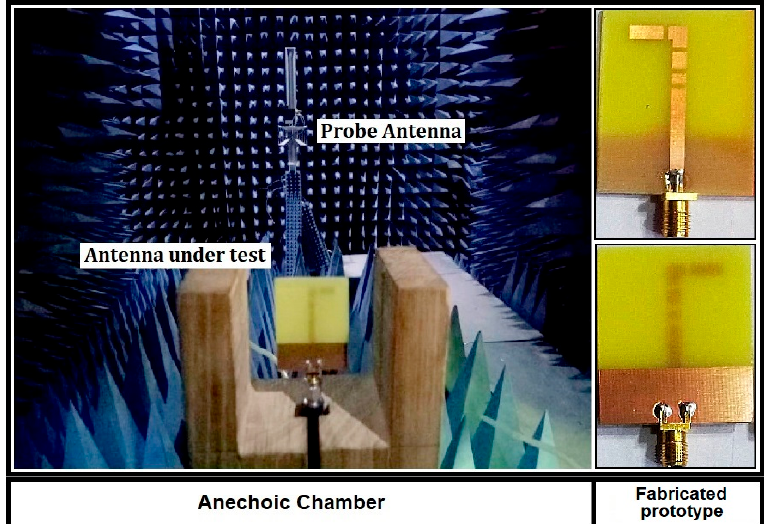
Figure 4. Setup for measuring radiation pattern of the proposed antenna in Mode 1.